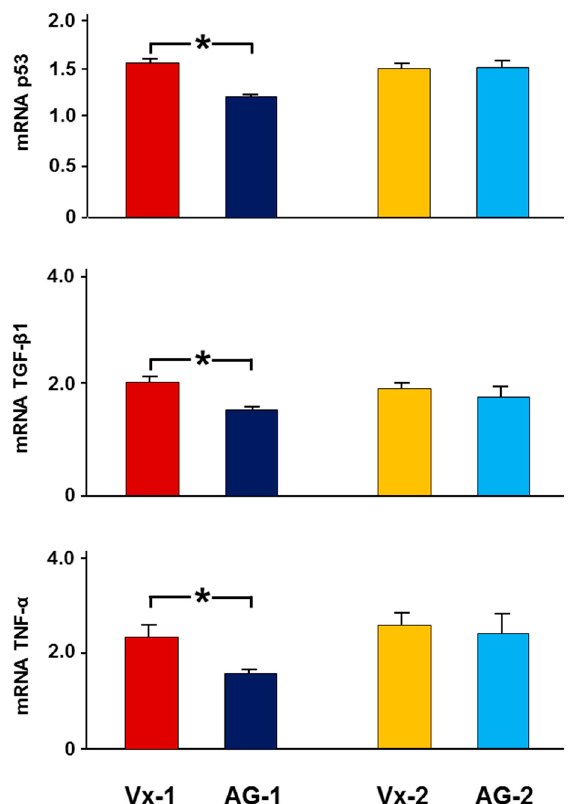
Figure 3. The expression of TNF- α , TGF- β 1, and p53 in all groups. The results are expressed as the mean fold changes of gene expression in the left kidney compared to right kidney. Values represent mean ± SEM. * indicates statistical significance between corresponding groups.